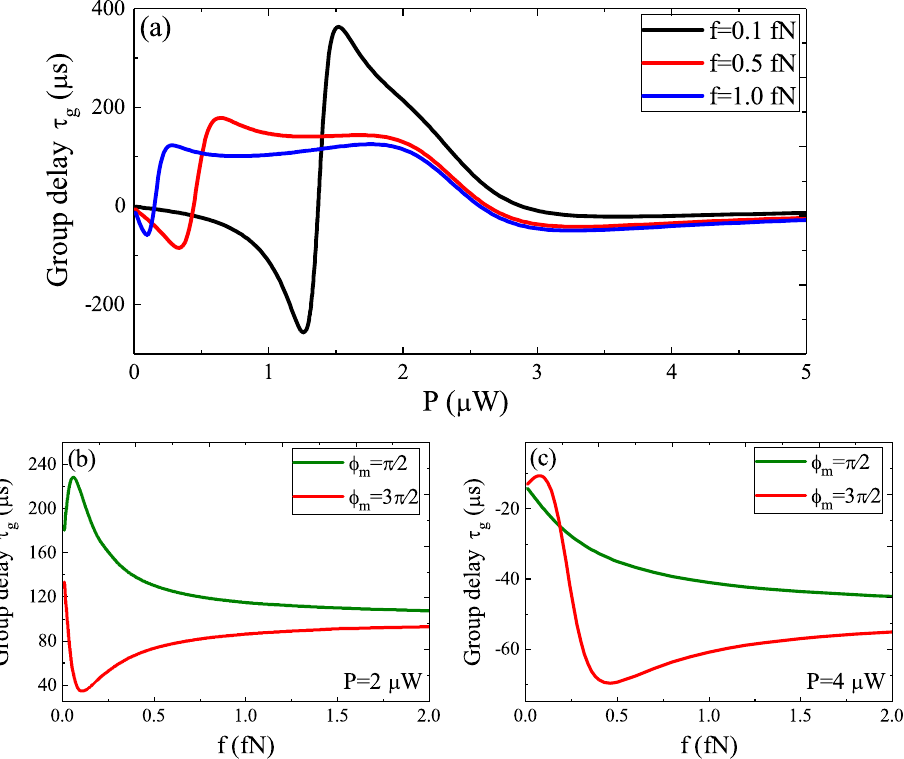
Figure 3. ( a ) The group delay τ g as a function of optical pump power P for three driving amplitudes f . ( b ) The group delay τ g versus f for two different pump phases ϕ m at P = 2 µ W. ( c ) The group delay τ g versus f for two different pump phases ϕ m at P = 4 µ